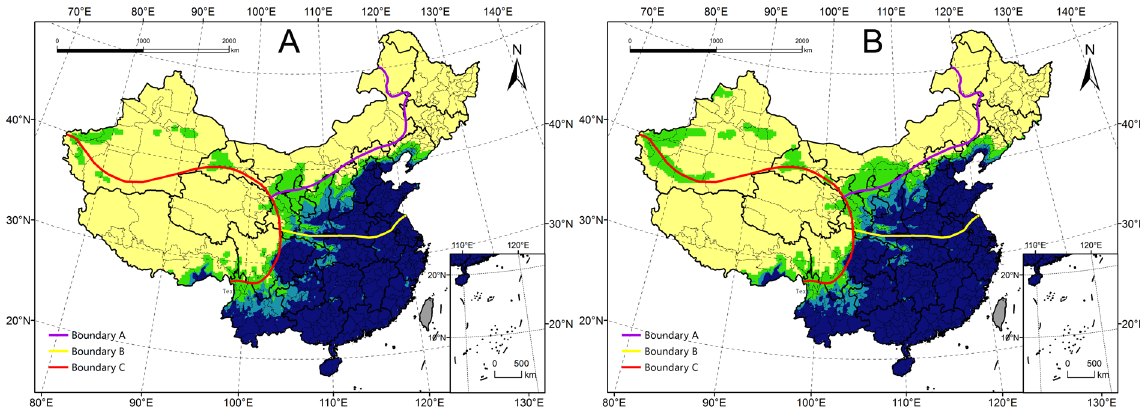
Figure 11. Potential distribution maps with geographic boundary lines. Purple line (Boundary A ) is the boundary of the Region and North Region, yellow line (Boundary B ) is the boundary of the South Region and North Region, red line (Boundary C ) is the boundary distinguishing the Qinghai-Tibet Region with other three regions. The maps in this figure were generated by GIS software (ArcGIS for Desktop, Software Version 10.2, http://resources.arcgis.com/en/home/) with map layer